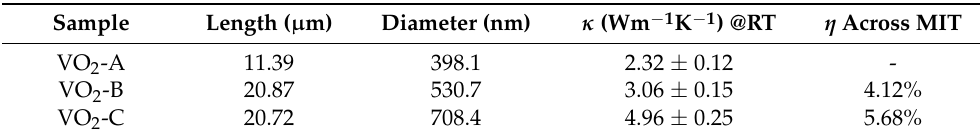
Table 1. Parameters of the VO 2 nanowires used for the thermal conductance. The lengths and diameters of the VO 2 nanowires were measured by